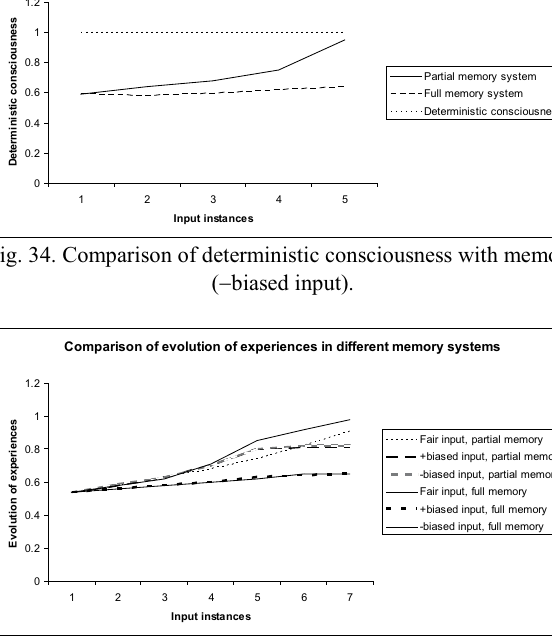
Fig. 35. Comparison of evolution of experiences in different memory and